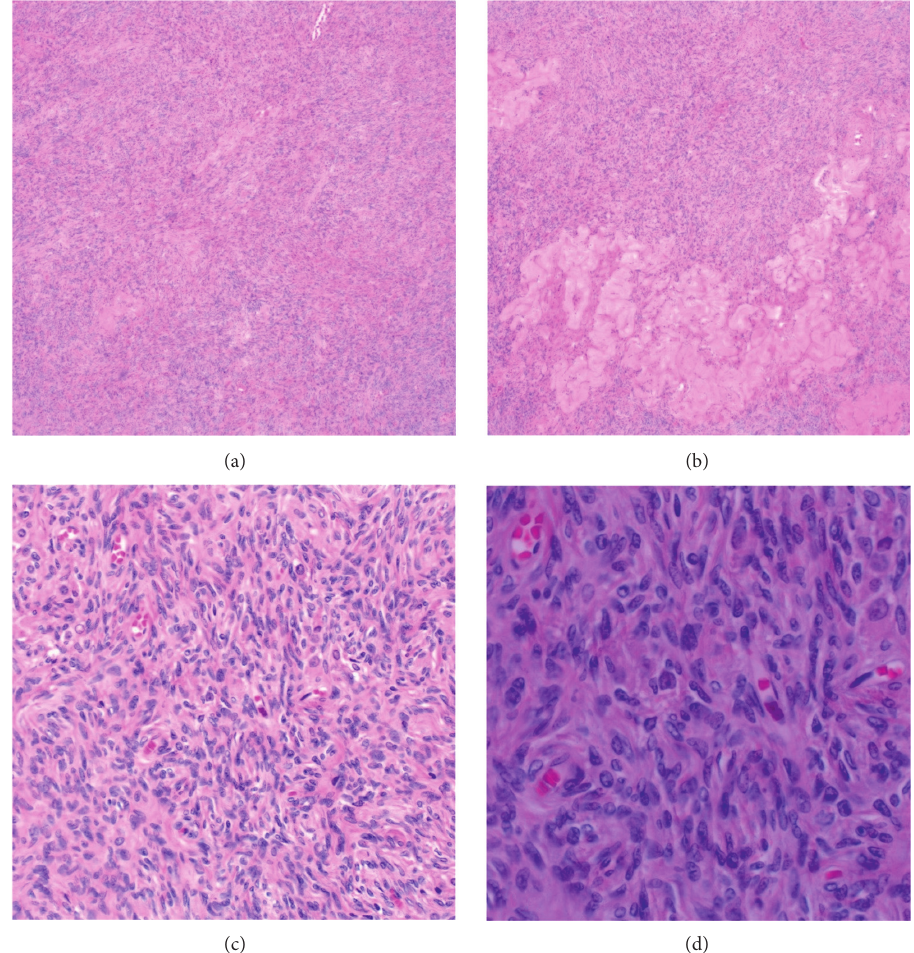
Figure 1: Microscopic images depict ovarian hyperthecosis with stromal hyperplasia and abundant spindled theca cells. Corpora albicantia (B) was also apparent throughout the specimen. Hematoxylin and eosin stain, original magnification: (a) 4x, (b) 4x, (c) 20x, and (d) 40x.